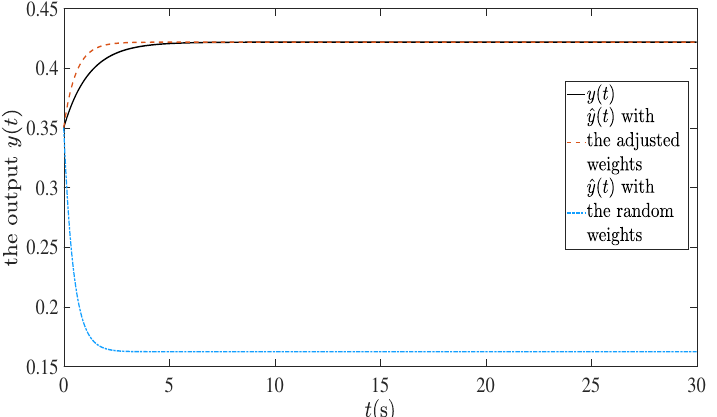
Figure 12. The output and estimated output with the adjusted weights and output with the random weights